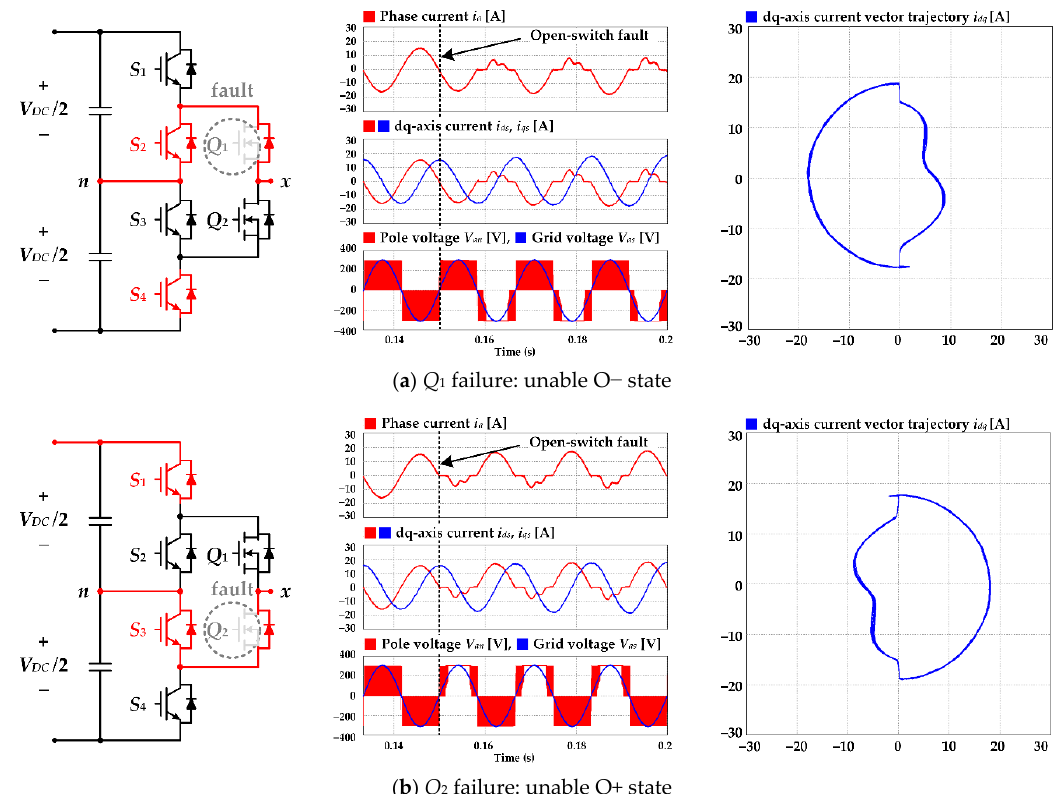
Figure 6. Phase current and pole voltage under each MOSFET faulty condition in the HANPC rectifier.